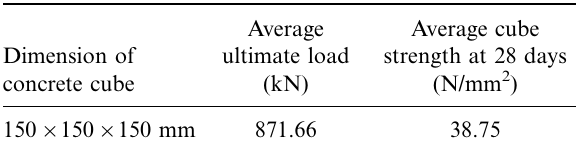
Table 1. Details of concrete mixes Dimension of concrete cube